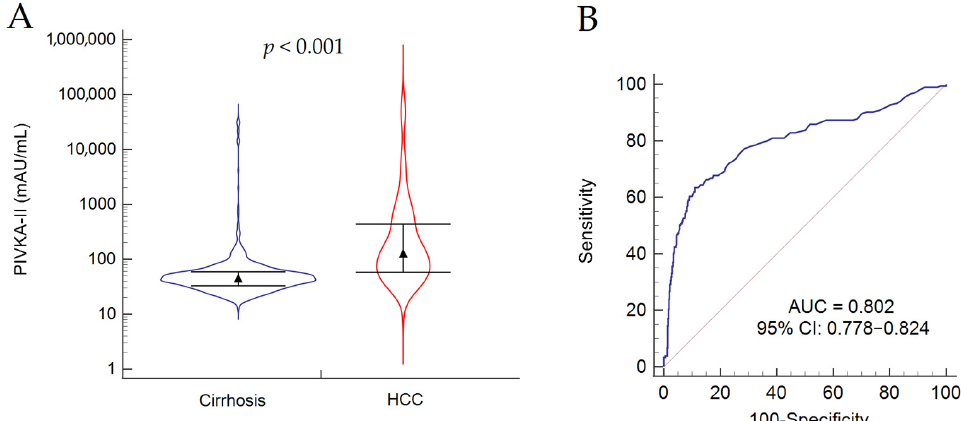
Figure 1. PIVKA-II serum values in patients with cirrhosis and in those with HCC ( A ) and corresponding ROC curve for the discrimination between patient with and without HCC at baseline ( B ). PIVKA-II values in patients with cirrhosis without HCC: median 45 mAU/mL (IQR 33–59). PIVKA-II values in patients with HCC: median 128 mAU/mL (IQR 58–435). Abbreviations: AUC, area under the curve; CI, confidence interval; FU, follow-up; HCC, hepatocellular carcinoma; PIVKA-II, protein induced by vitamin K absence or antagonist